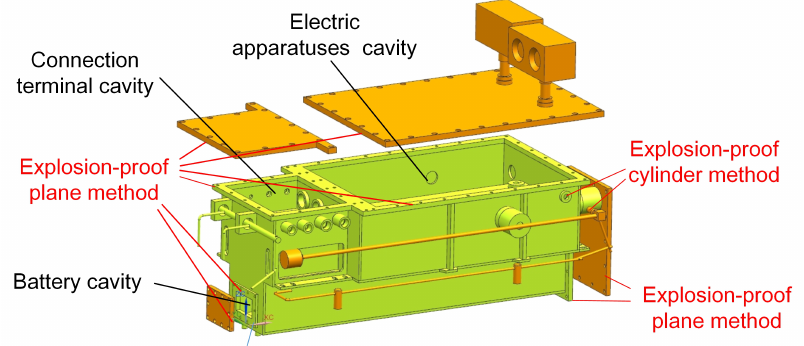
Figure 20. The mechanical explosion-proof method of the robot electric